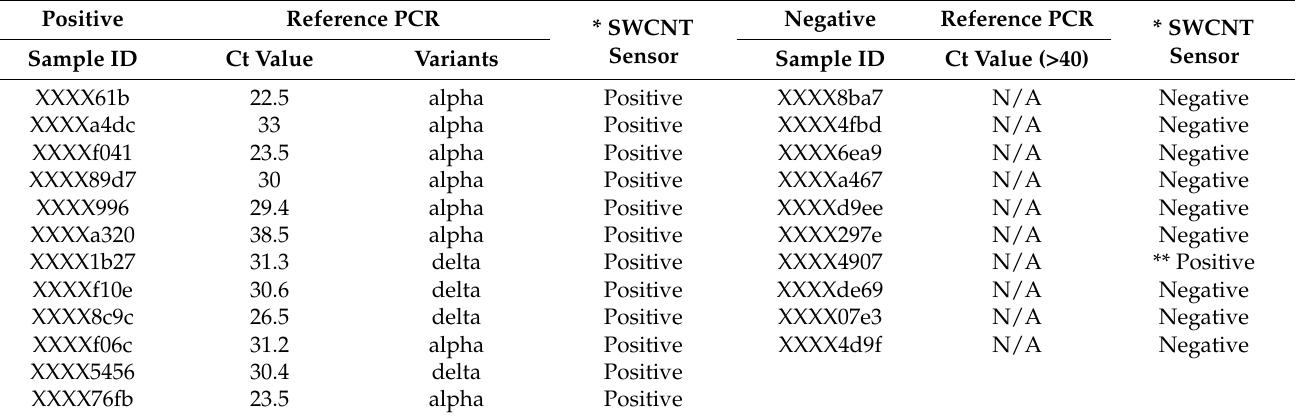
Table 3. Comparison of PCR results and SWCNT sensor results for positive and negative clinical samples (N/A means Ct >